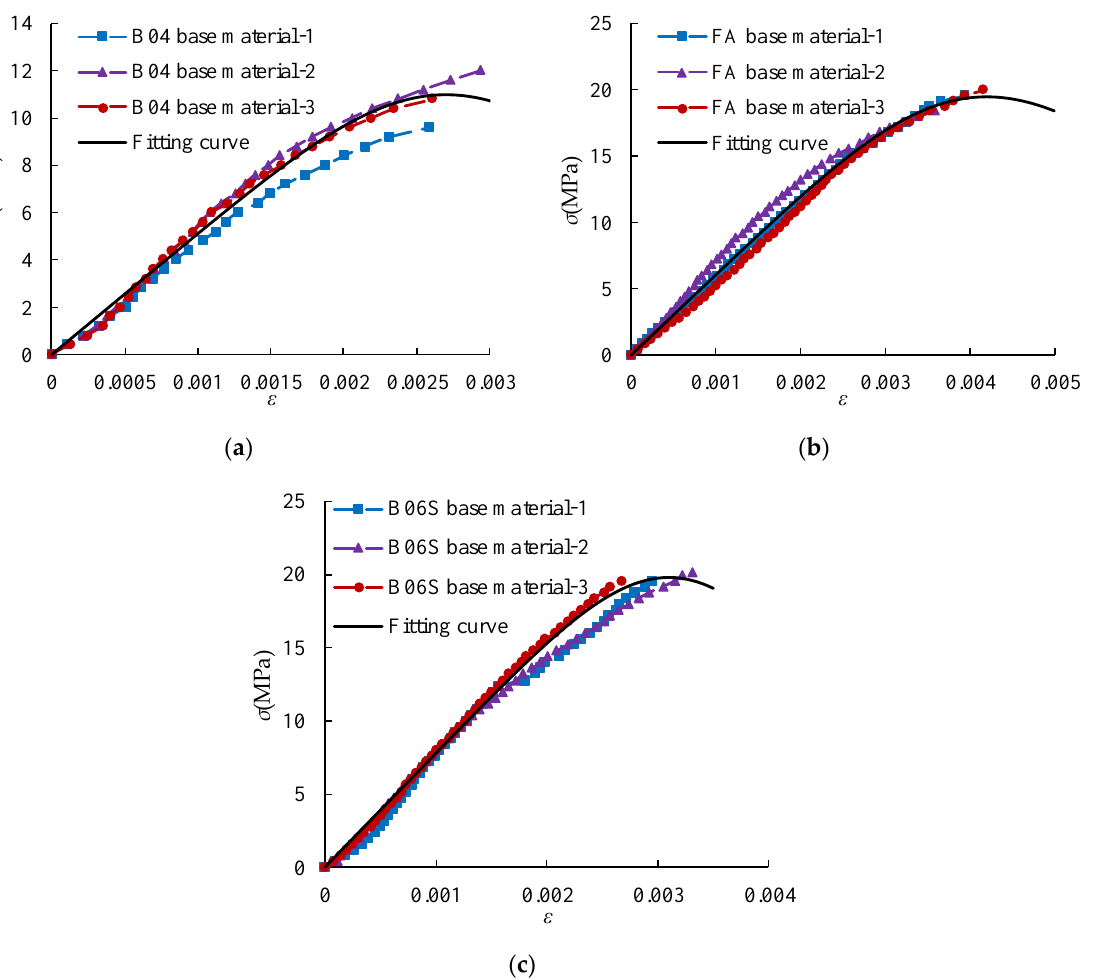
Figure 18. Stress–strain relationship and fitting curve of base material: ( a ) B04; ( b ) B06FA; ( c ) B06S.